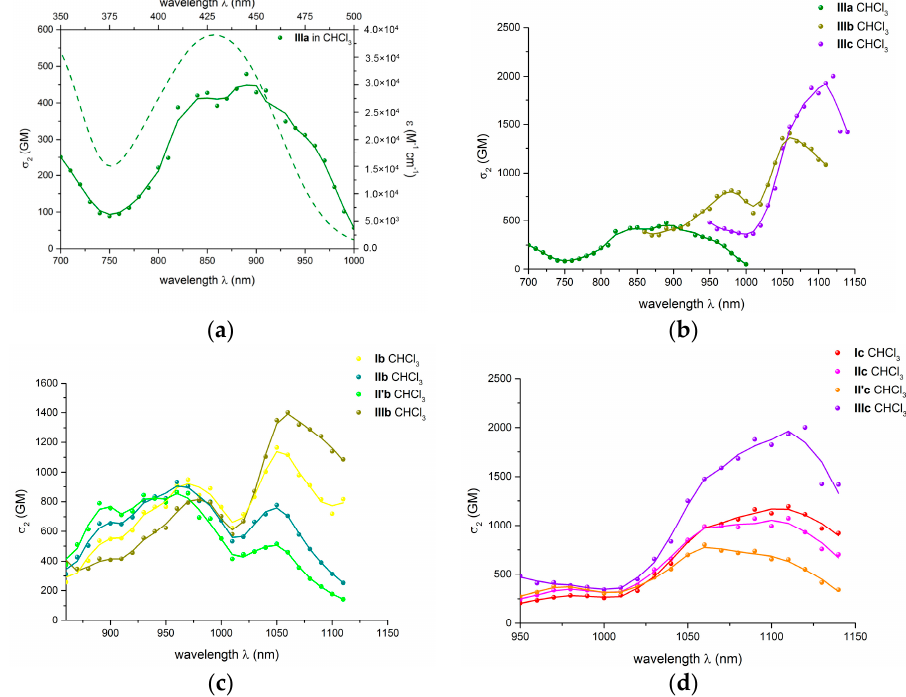
Figure 2. ( a ) 1PA (dashed line) and 2PA (colored points and solid line) spectra measured for the chromophore IIIa in CHCl 3 ; ( b ) Comparison between two-photon absorption spectra for the dyes IIIa – c in CHCl 3 ; ( c ) Comparison between the 2PA spectra of derivatives I – IIIb in CHCl 3 ; ( d ) Comparison between the 2PA spectra of derivatives I – IIIc in CHCl 3 .